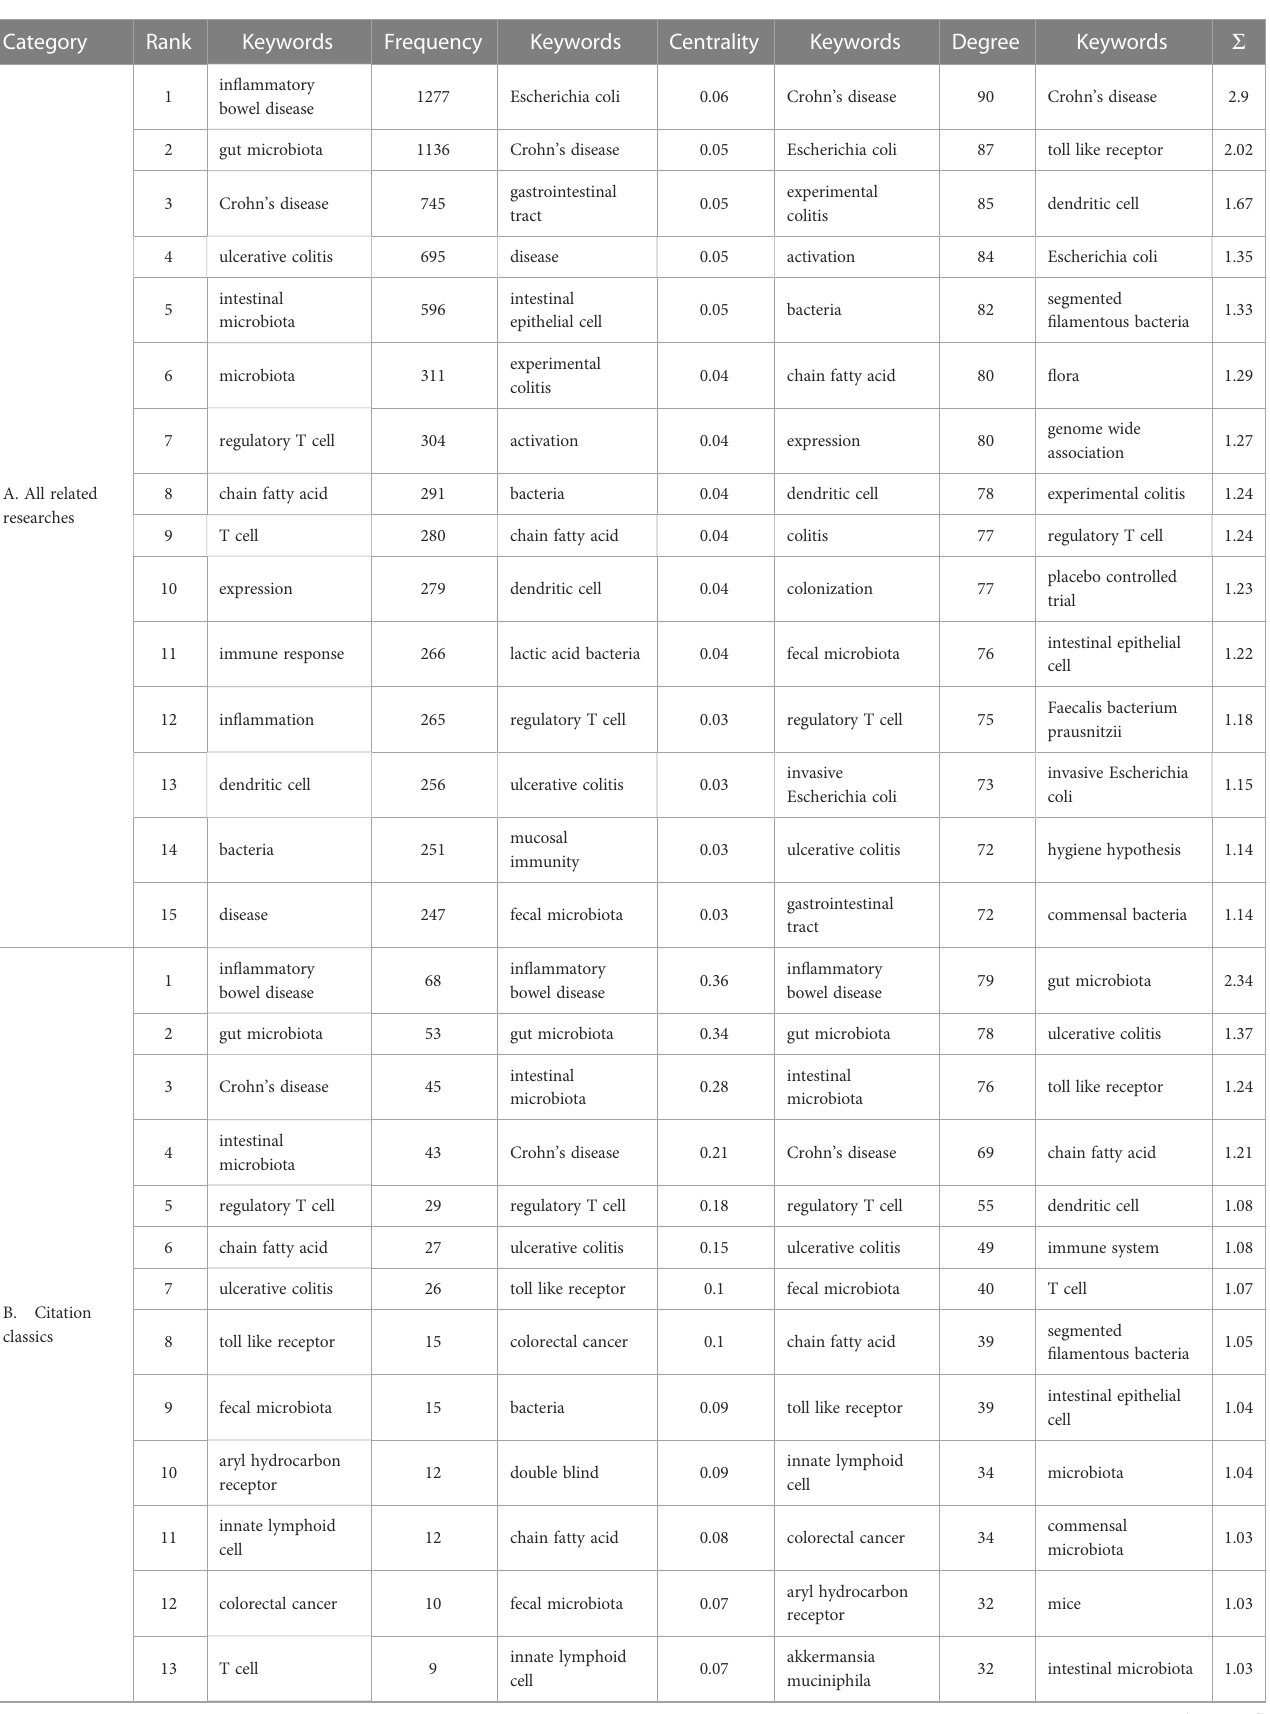
TABLE 1 Top 15 keywords of relevant literature. Category